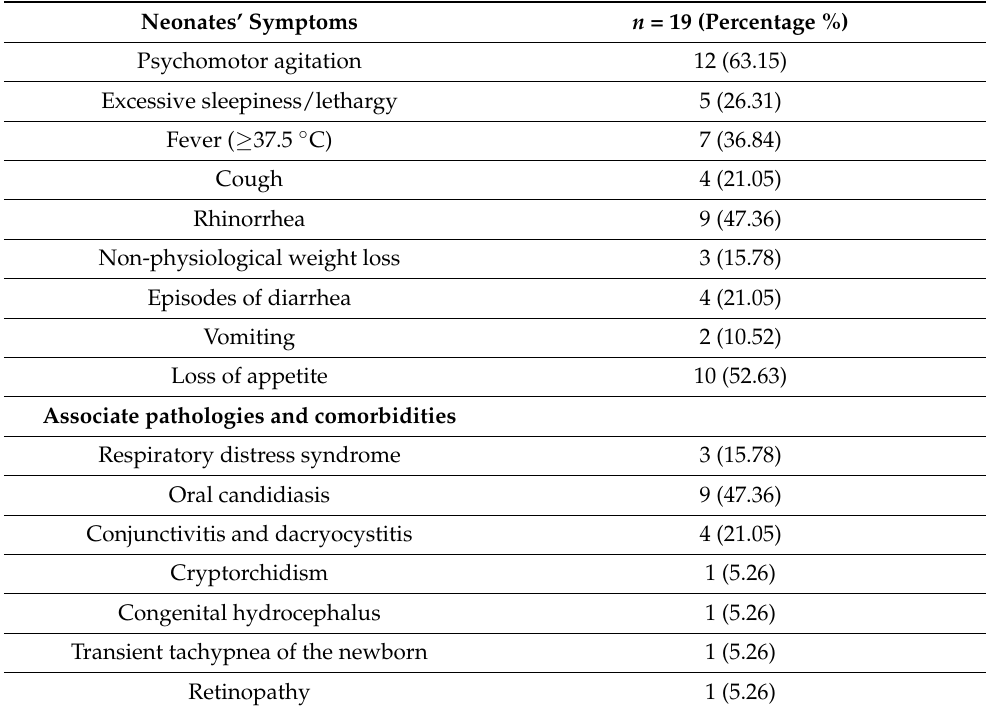
Table 3. The symptoms and comorbidities of neonates with COVID-19 pneumonia presented as the number of patients and percentage (%) of the lot.